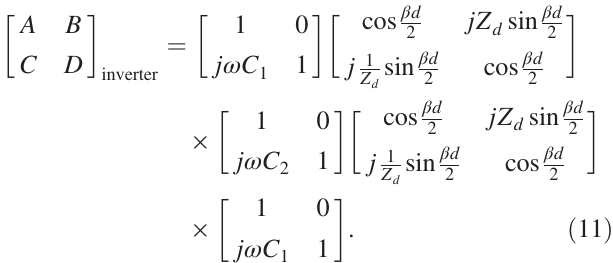
FIG. 6. Dimensions of unit cells of the birefringent board. (a) Outer sheet and (b) inner sheet